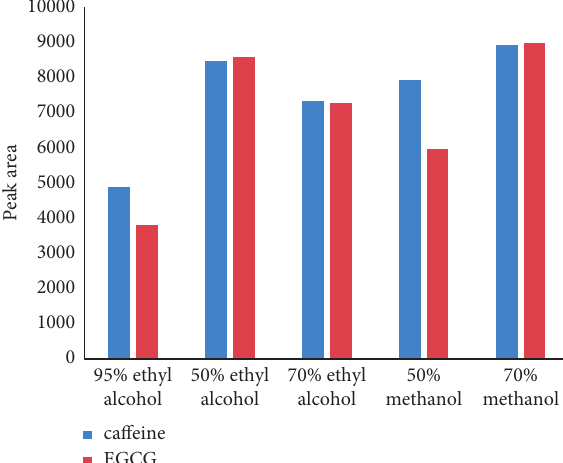
Figure 4: The peak area of two ingredients was compared under different extraction